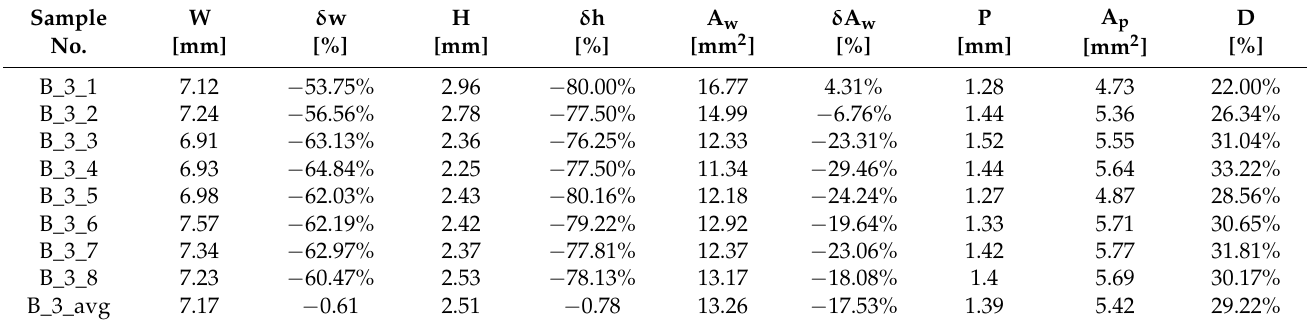
Table A8. Measurements of dimensional features of 3rd parameter set of Wire B—wire feed